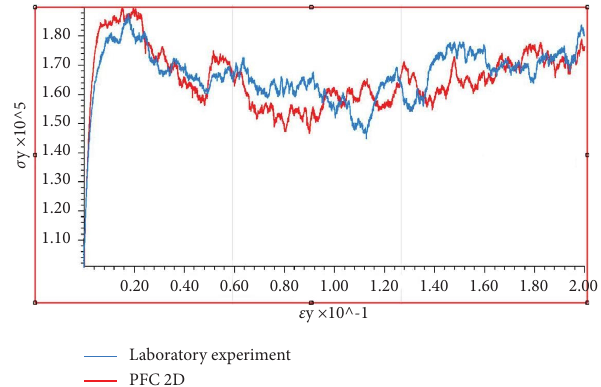
Figure 10: Comparison of stress-strain between laboratory ex- periment and discrete element